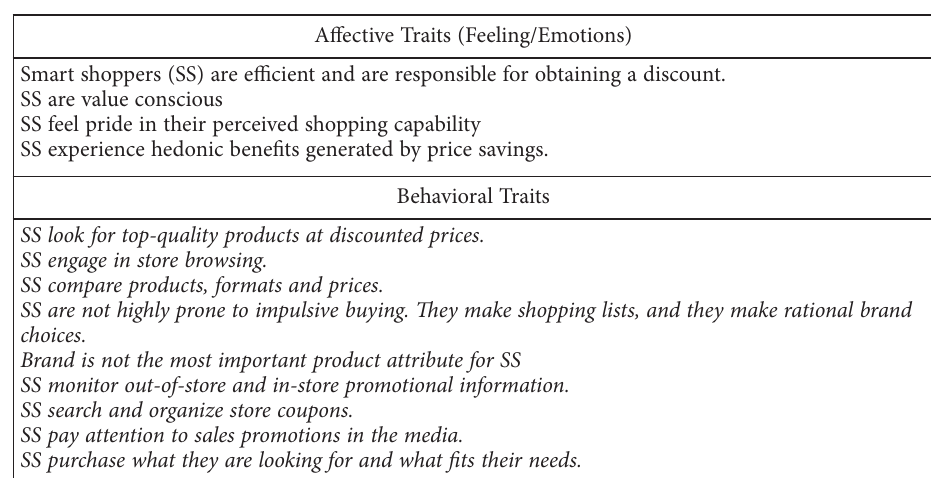
Table A1. Key information gathered in the in-depth